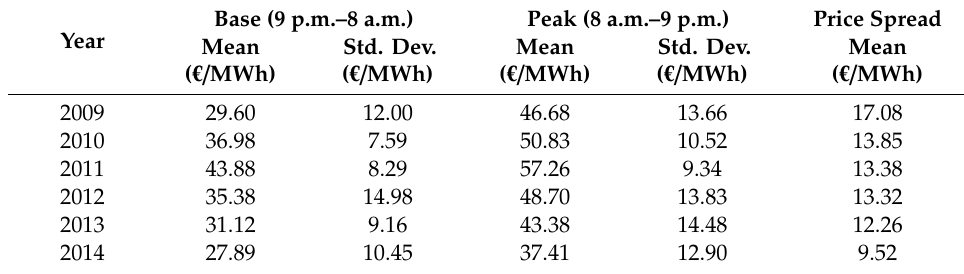
Table 9. Mean and standard deviation of EEX base- and peak-power spot prices from